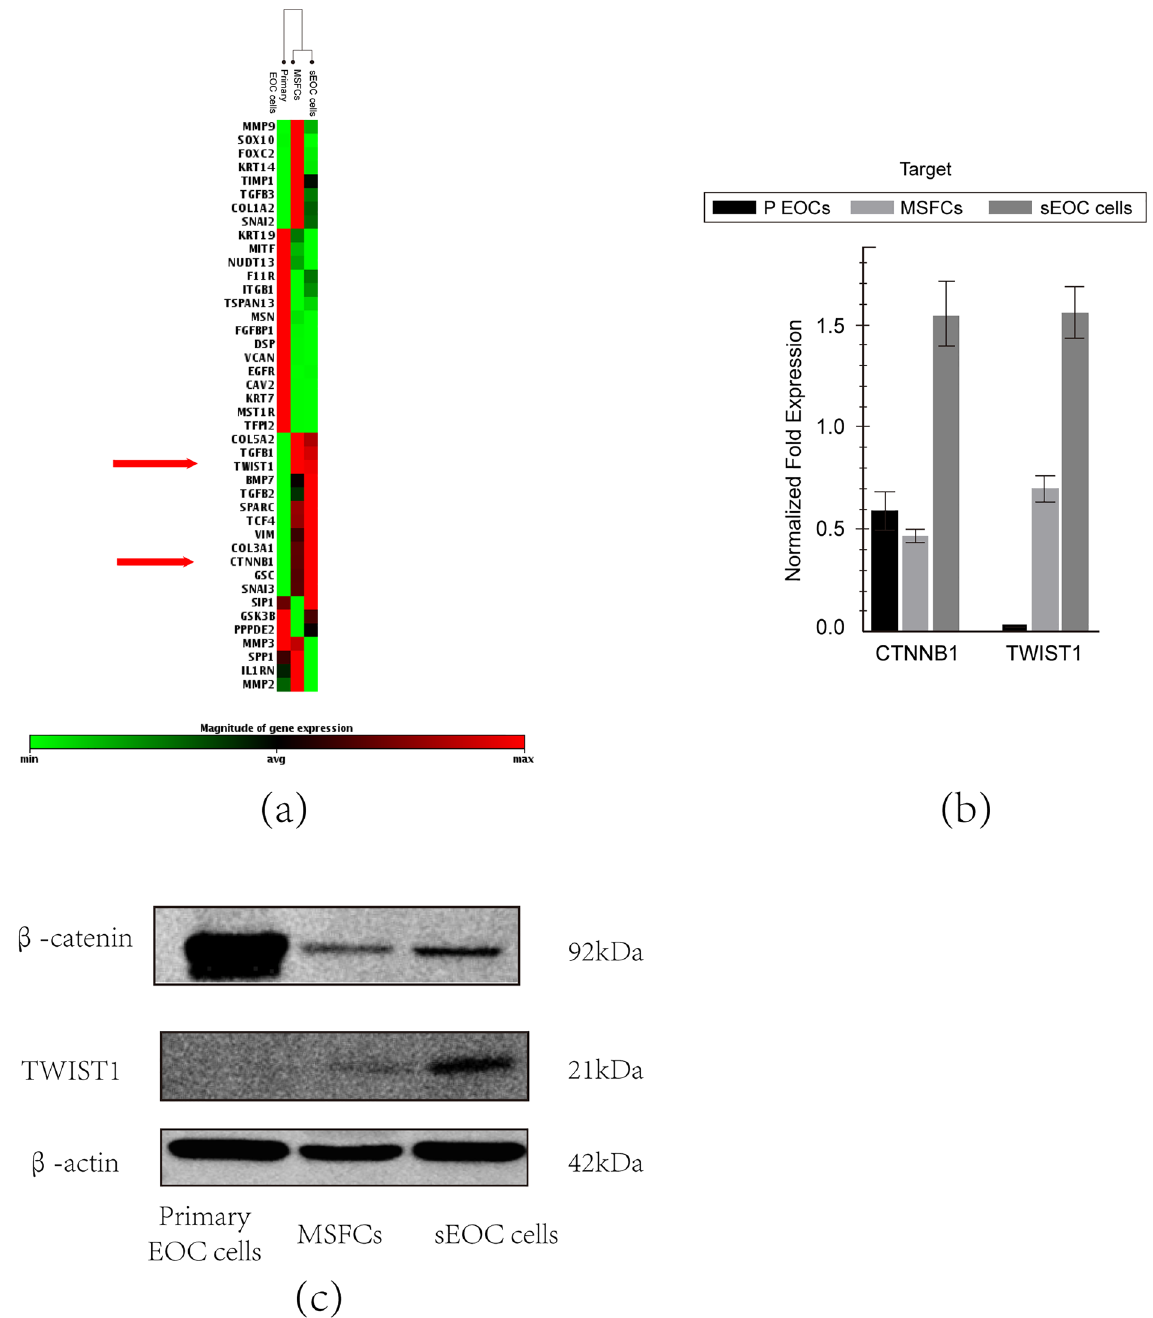
Figure 1. Expression of CTNNB1 and β-catenin in primary EOC cells, MSFCs and sEOC cells. ( a )The EMT array showed that the transition from primary EOC cells (P EOC cells) to MSFCs and sEOC cells is characterized by the upregulation of genes associated with EMT and MET. Array was performed using 3 clones for each stage of differentiation; genes with p < 0.05 are shown. ( b )qPCR analysis of CTNNB1 mRNA isolated from P EOCs, MSFCs and sEOC cells. Three replicates of each gene were performed for each experiment. Data are representative of three independent experiments. * p < 0.05, Student’s t test. ( c )Western blot of β-catenin and TWIST1 protein expression in ovarian cancer cell lines. Data are representative of three independent